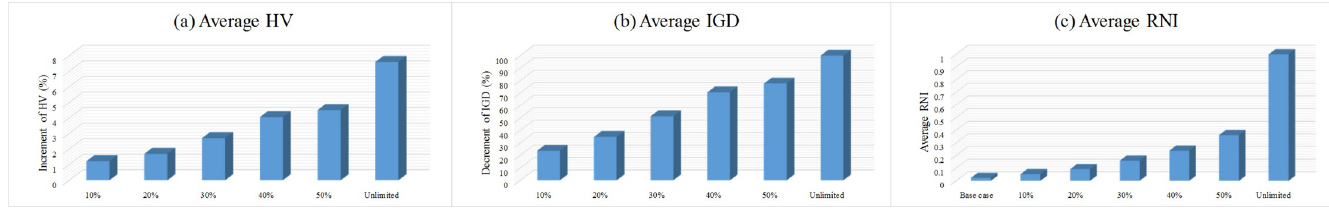
Fig 7. Effects of depot capacity on the performance indicators (only HV, IGD, and